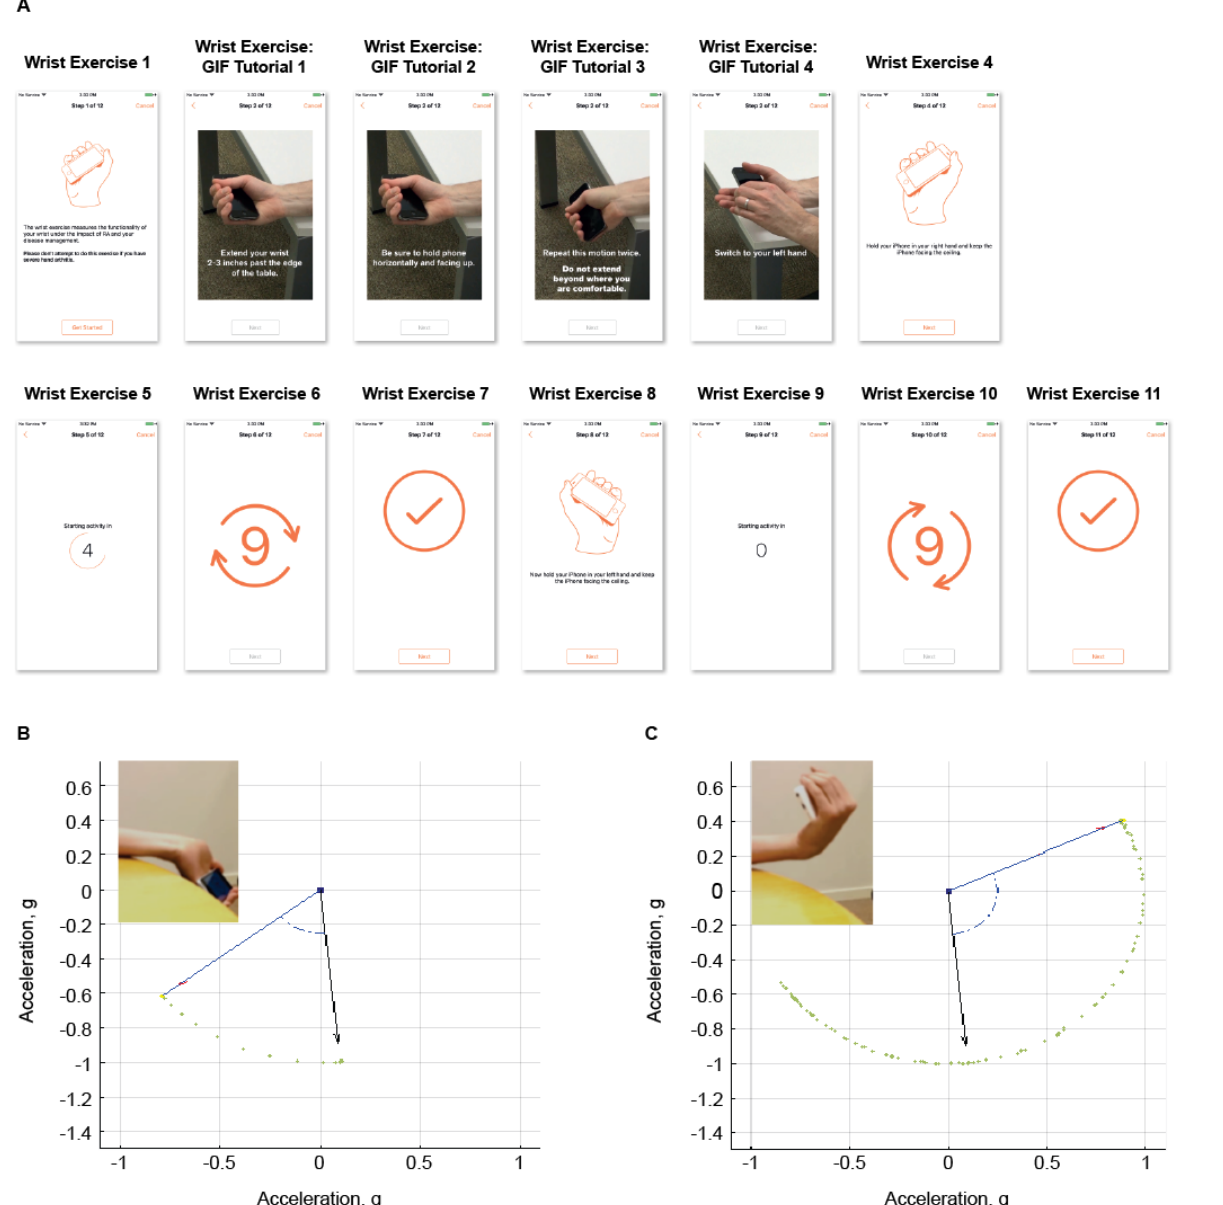
Figure 1. Wrist range of movement (ROM) exercise. (A) Instructions for the wrist ROM exercise provided to participants via the app. (B, C) Wrist ROM preliminary validation based on experimental test data. (B) Relative change in phone orientation (blue arrow) at full wrist extension with respect to initial orientation (black arrow). (C) Relative change in phone orientation at full wrist flexion. In both examples, the video frame from the task performance at the moment of measurement is displayed as a reference for visual inspection. Green dots correspond to phone orientation at previous